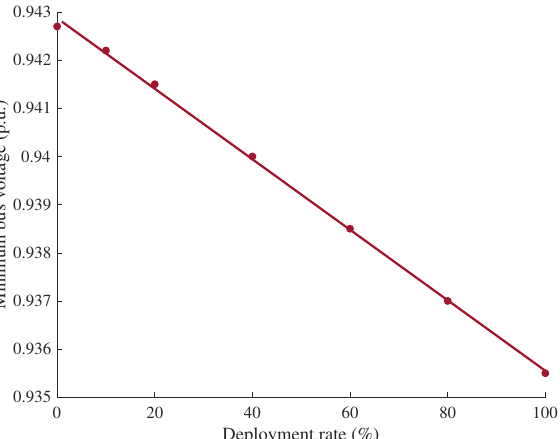
Figure 14. Daily minimum bus voltage with different EVs deployment rate.